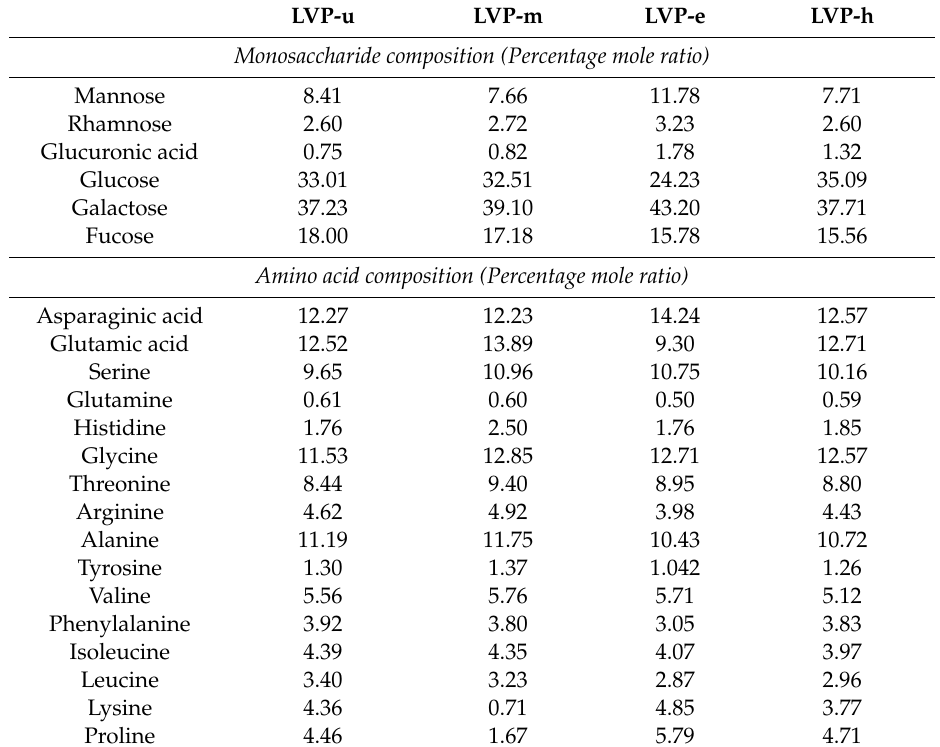
Table 2. Monosaccharides and amino acid compositions of LVPs extracted by di ff erent methods.